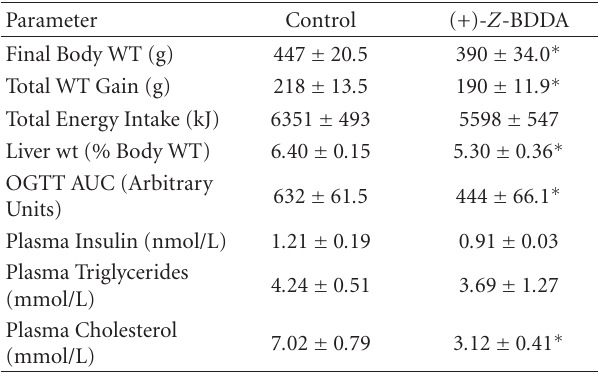
Table 2: Metabolic parameters in female obese Zucker rats ( n = 8) provided (+)- Z -BDDA for 11